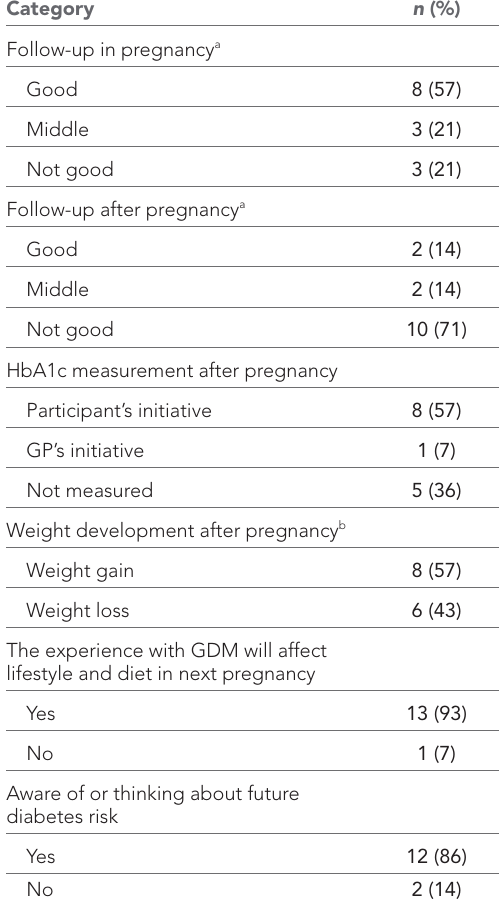
Table 3 Study participants' experiences of GDM follow- up, weight development, and attitudes to future diabetes risk ( n =